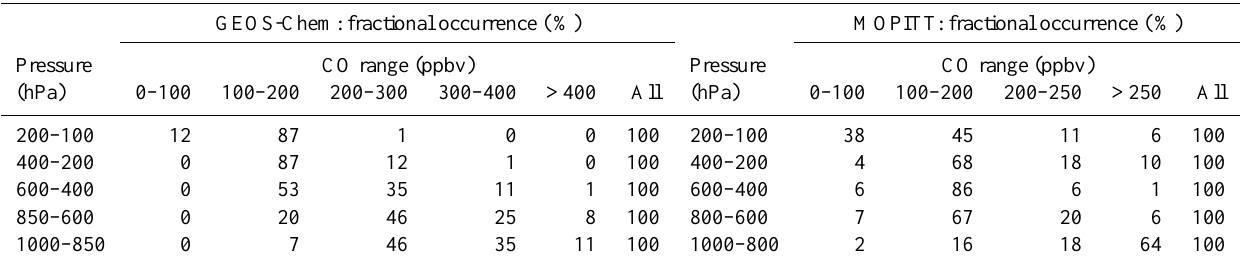
Table 3. Occurrences of various CO ranges in GEOS-Chem simulations and MOPITT observations in the vicinity of Narita (126–140 ◦ E 30–40 ◦ N) in